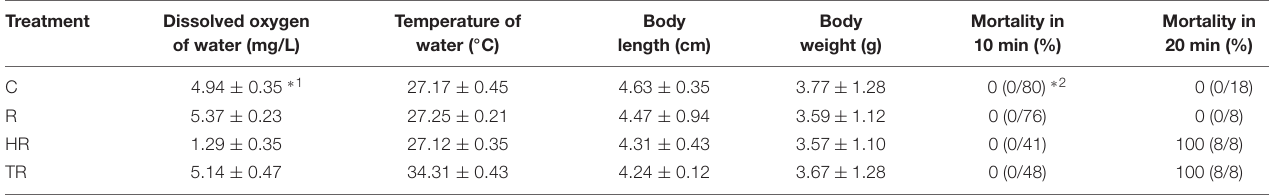
TABLE 2 | Water parameters, fish length and weight, and mortality in control (C), restricted (R), hypoxic (HR), and thermal (TR) treatment non-ABR groups. Treatment Dissolved oxygen of water